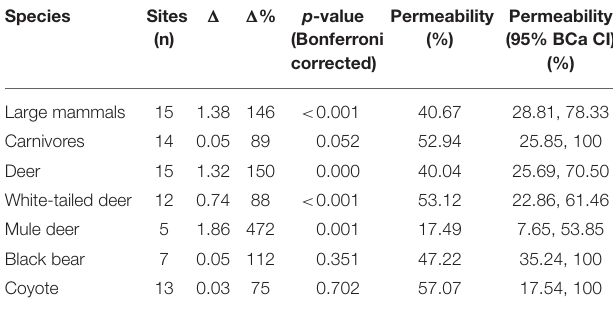
TABLE 3 | Performance measures (average daily differential and percentage difference) for each species and species group and estimated percentage of road permeability required for 100% connectivity through the road corridor compared to movement rates in immediately surrounding